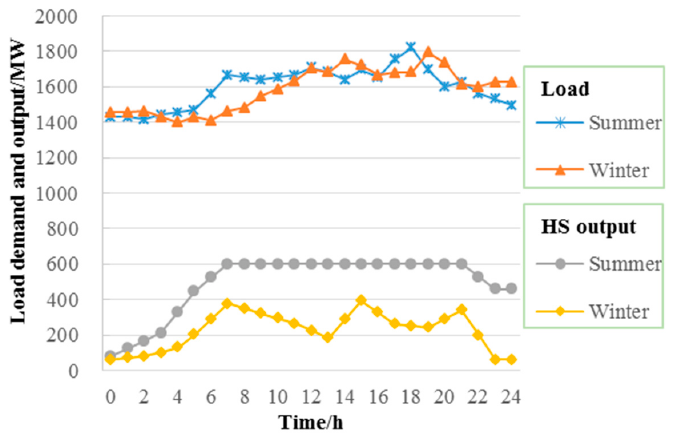
Figure 4. The load demand and the available output of the hydropower station (HS) on a typical load day.